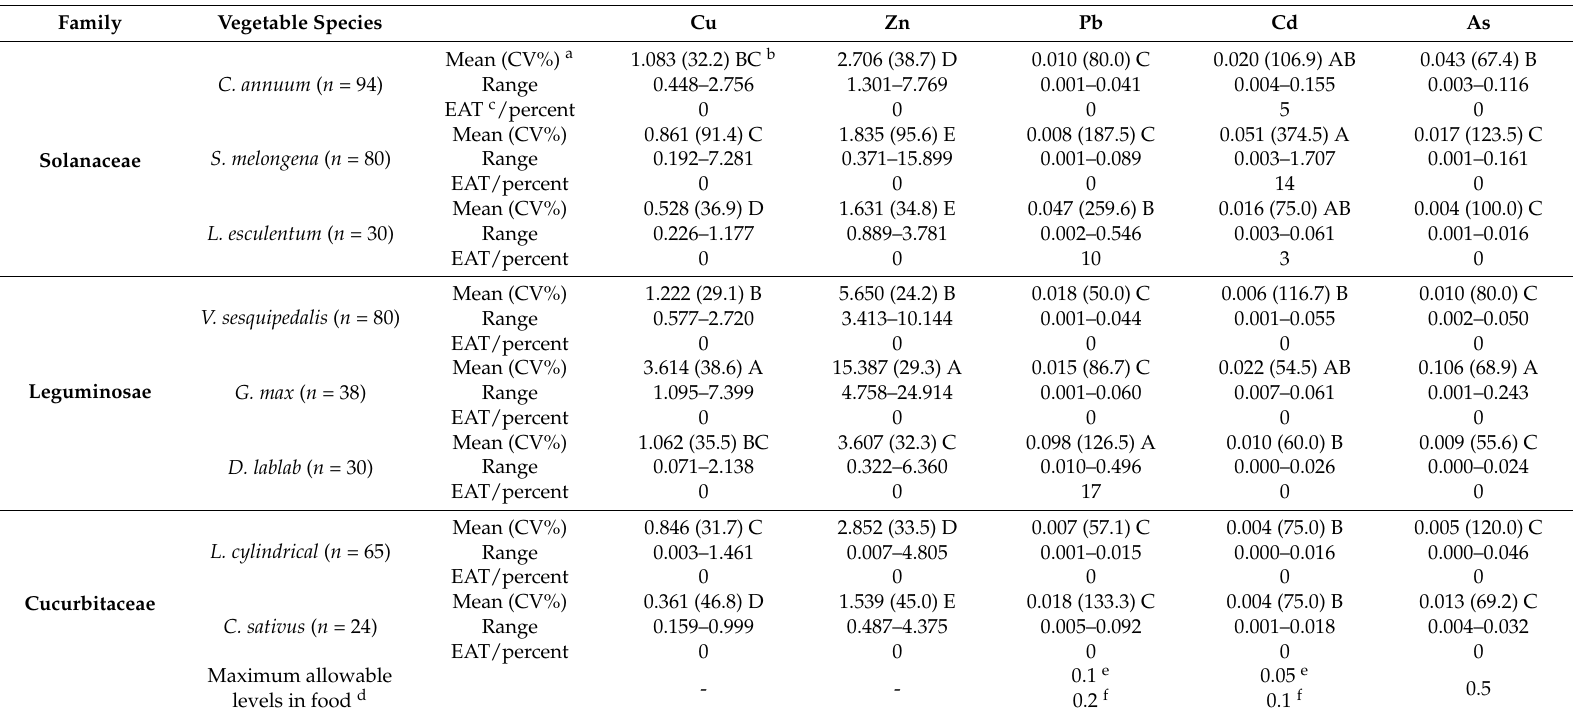
Table 3. Contents of trace elements in the fruit vegetables. (mg kg − 1